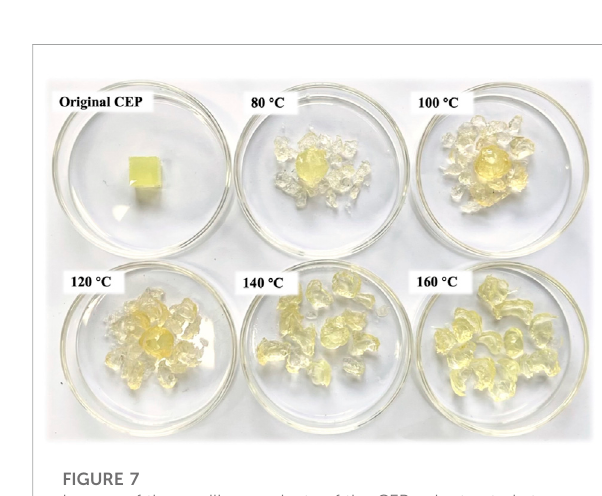
FIGURE 6 Possible delamination process of CFRP in DMAC.